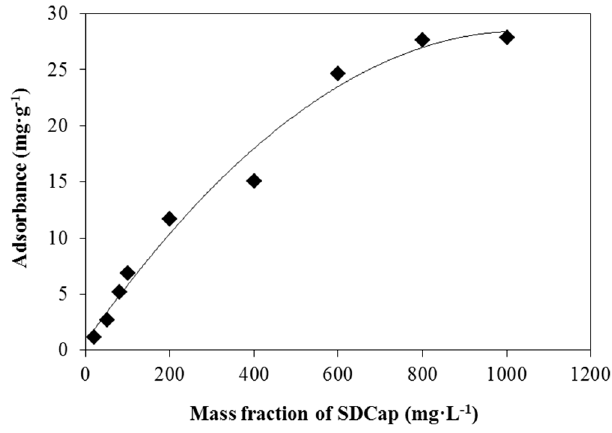
Figure 7. Variations of adsorbance of SDCap on clay particles as a function of concentration.